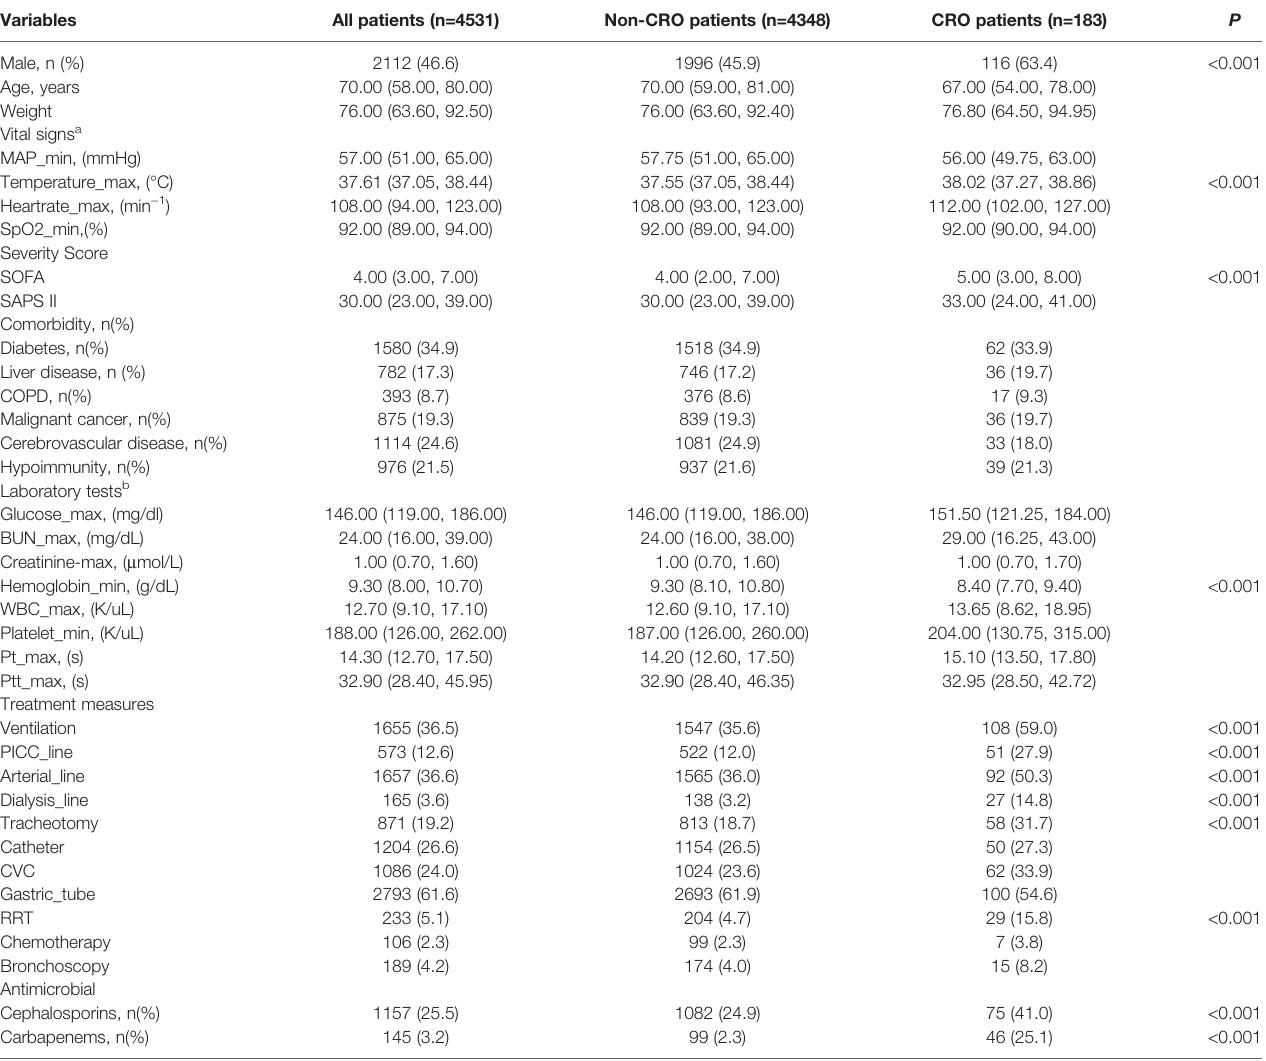
TABLE 1 | The characteristics of included patients when the fi rst ICU admission. Variables All patients